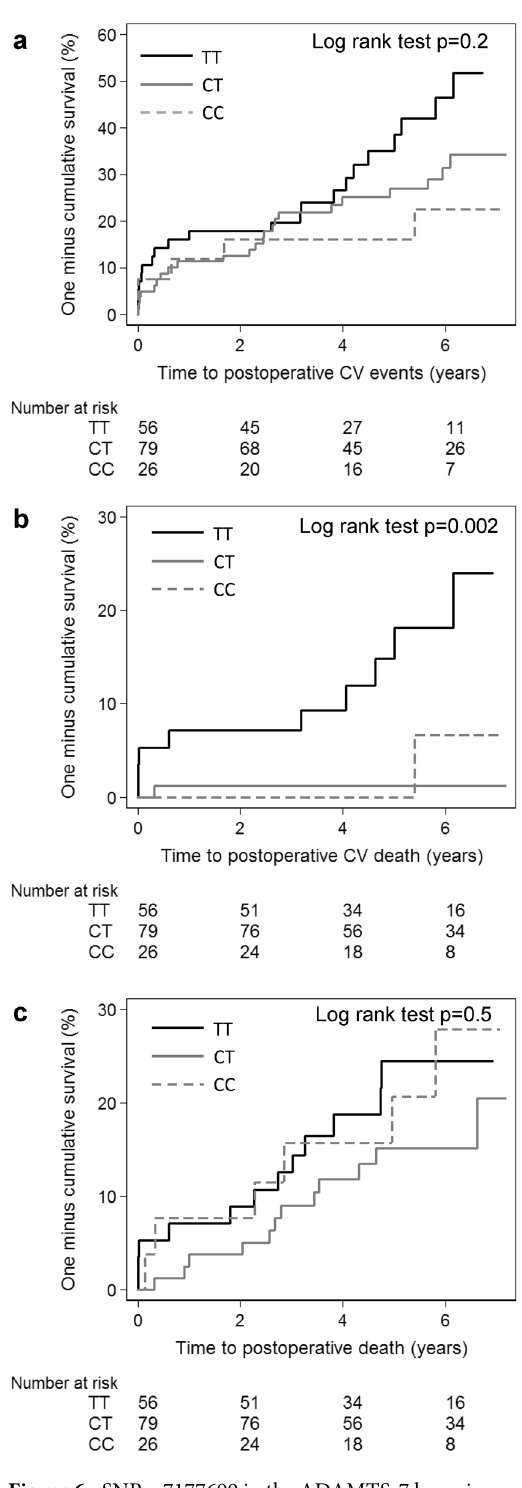
Figure 6. SNP rs7177699 in the ADAMTS-7 locus is associated with increased risk for a future CV death. Kaplan-Meier curves illustrating risk for postoperative CV events ( a ), CV deaths ( b ) and all causes deaths ( c ) across ADAMTS-7 genotypes in SNP